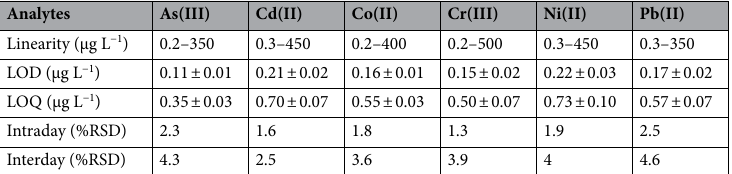
Table 3. Analytical performances of UA-DSPME/ICP-OES method.